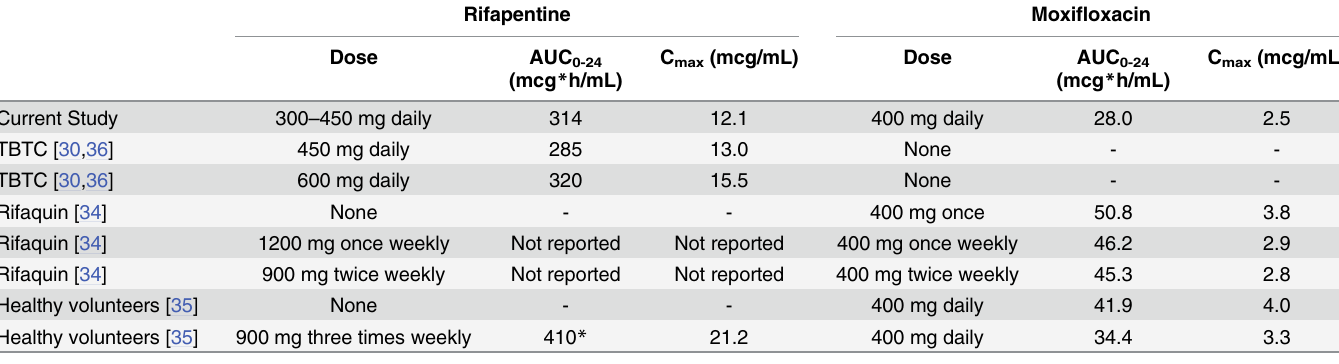
Table 4. Average rifapentine and moxifloxacin pharmacokinetic parameter estimates in the current study compared to other recent studies using rifapentine alone or given together with moxifloxacin. Abbreviations: AUC 0-24 = area under the concentration-time curve over 24 hours; C max = maximum concentration; TBTC = Tuberculosis Trials